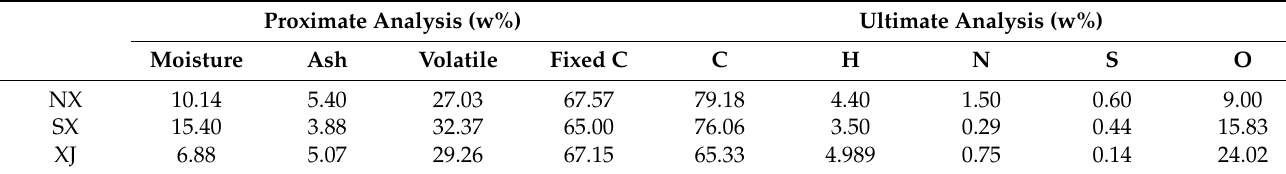
Table 1. Proximate and ultimate analyses of the coal